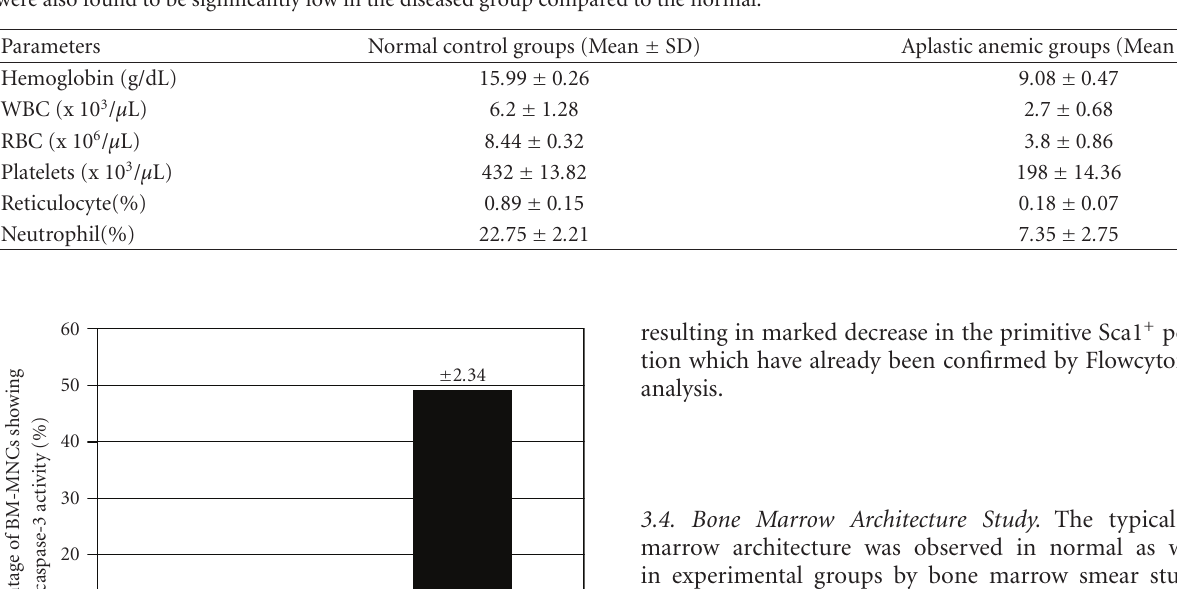
Figure 2: (a) Annexin-V positivity shown by Sca-1 + bone marrow cells in normal condition (0.46%). (b) Annexin-V positivity shown by Sca-1 + bone marrow cells in Aplastic anemia (3.05%) is much higher compared to the normal. Table 1: Peripheral blood hemogram showed a depressed hemoglobin level with uniformly reduced corpuscular counts, of which reticulocyte counts are significantly low ( ≤ 0 . 2) in Aplastic groups compared with the normal range. The total WBC and Neutrophil counts were also found to be significantly low in the diseased group compared to the normal.